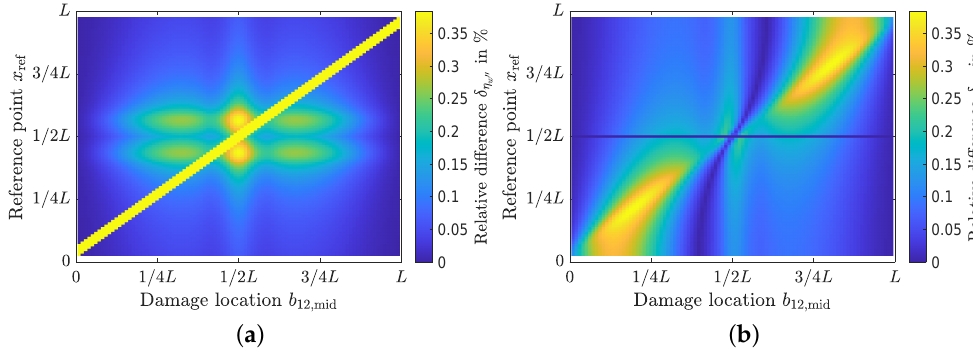
Figure 4. Relative difference between damaged and undamaged beams for different sensor positions and damage positions. ( a ) Relative difference δ η between damaged and undamaged beams for w (cid:48)(cid:48) the curvature influence line η w (cid:48)(cid:48) . The relative difference is coloured, and the limits are adjusted to the relative difference for displacement δ η in Figure 4b. In the diagonal there is a maximum w relative difference of 2.0395%. ( b ) Relative difference between damaged and undamaged beam for the displacement influence